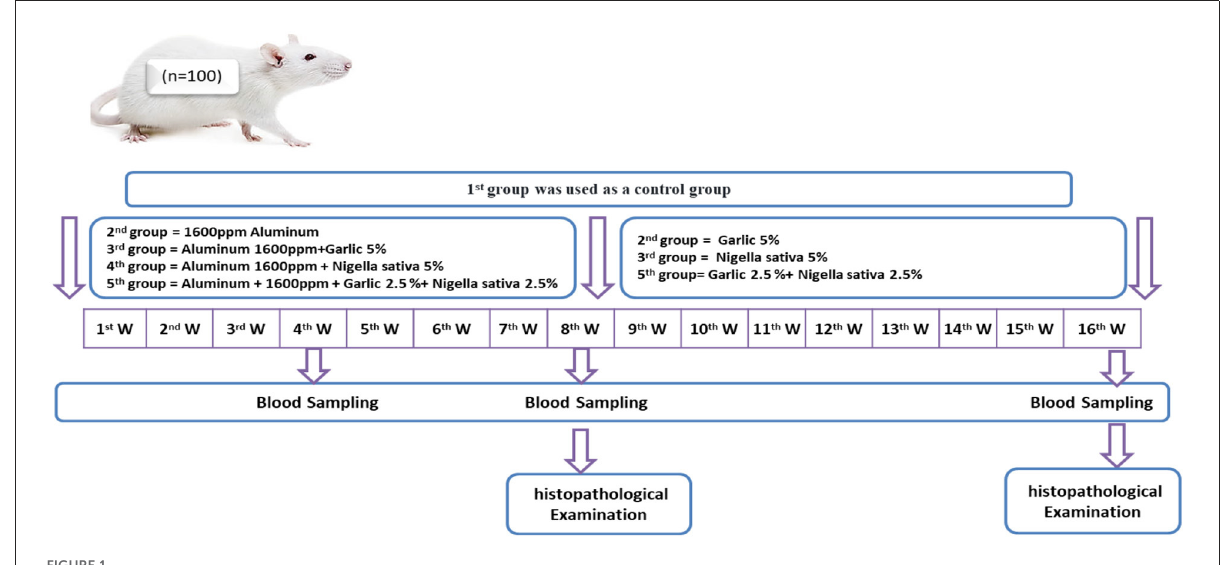
FIGURE1 Schematic diagram showing the experimental protocol for the effect of Allium sativum and Nigella sativa on reducing the negative consequences of Aluminum and returning liver, Kidney, and test to’ natural state in the Albino rats.